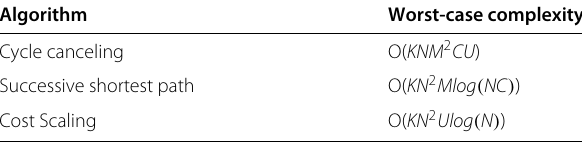
Table 1 Worst-case time complexity for min-cost algorithms